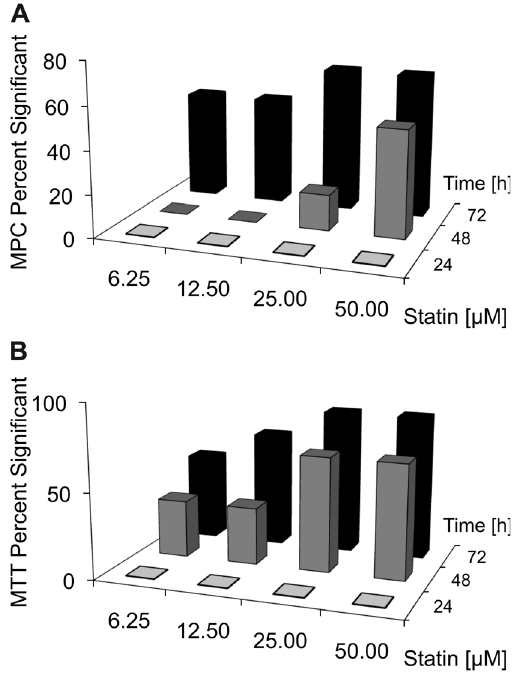
Figure 2. Effect of 6.25–50 m M statin treatment for 3 days on MPC and MTT proliferation. Percent significant results over all statins for all treatment doses at the different treatment durations for MPC (A) and MTT (B). The percentage of significant results was increased in MTT compared to MPC after 48 and 72 h, suggesting that MTT are more sensitive to statin